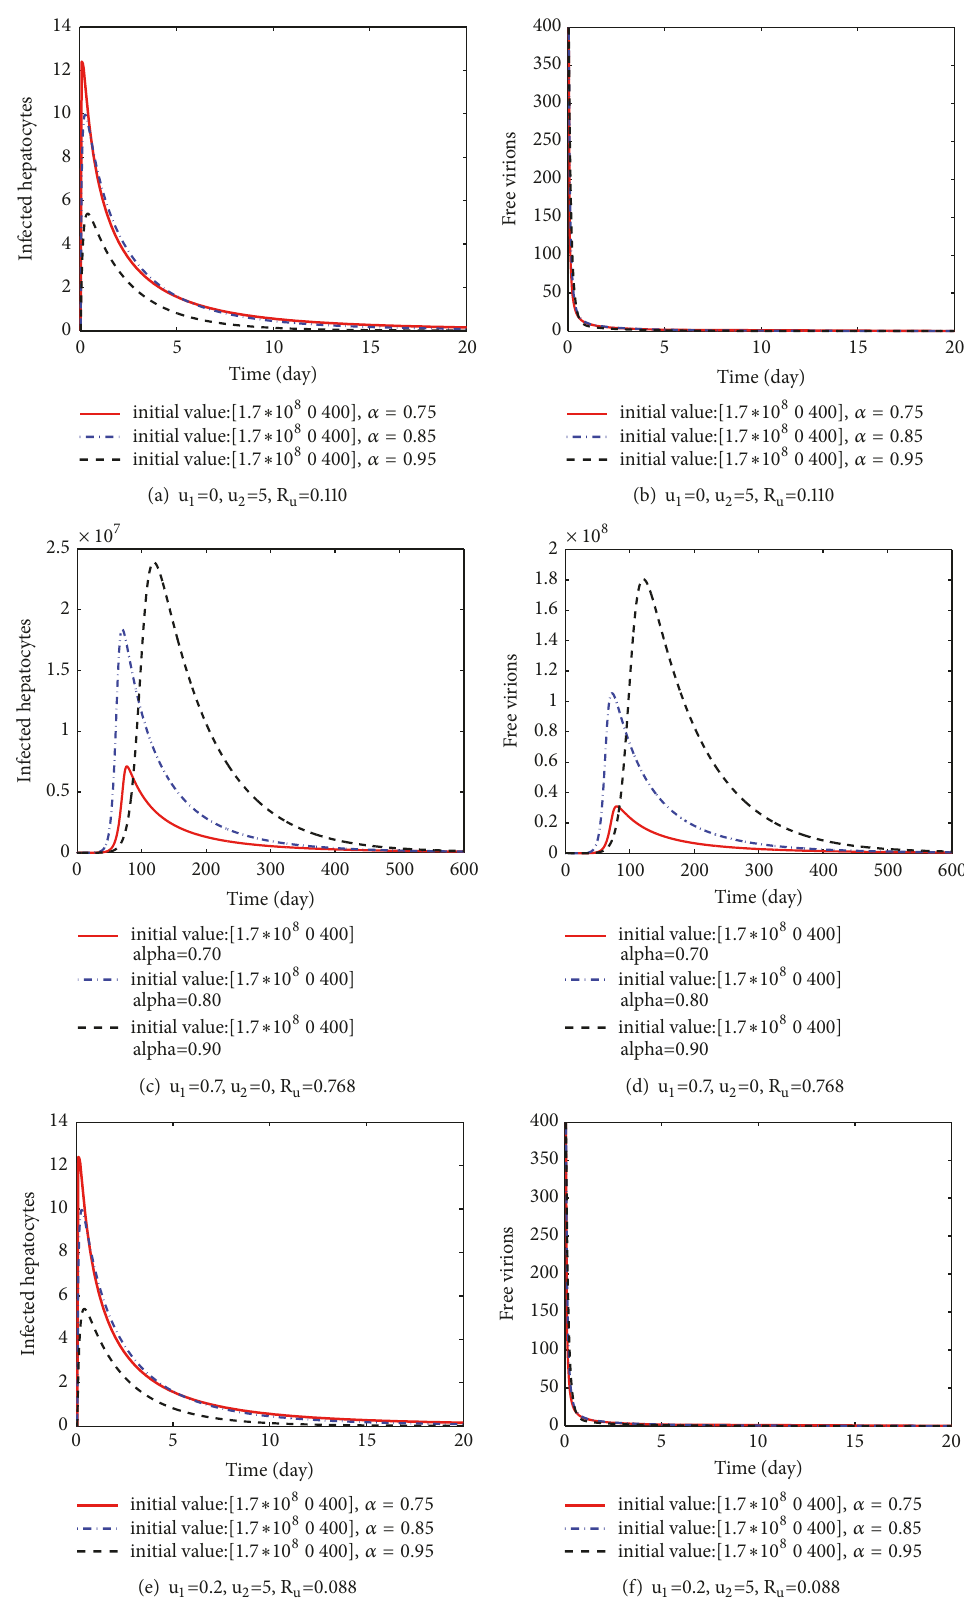
Figure 6: In this case, For different values of 𝛼 , when 𝑅 𝑢 < 1 , the disease-free equilibrium 𝐸 0 𝑢 = (Π/𝛿, 0, 0) = (1.667 × 10 8 , 0, 0) is always asymptotically stable. (a)-(b) Only LAM (without IFN) is used to treat HBV. (c)-(d) Only IFN (without LAM) is used to control HBV. (e)-(f) Both IFN and LAM are used to control